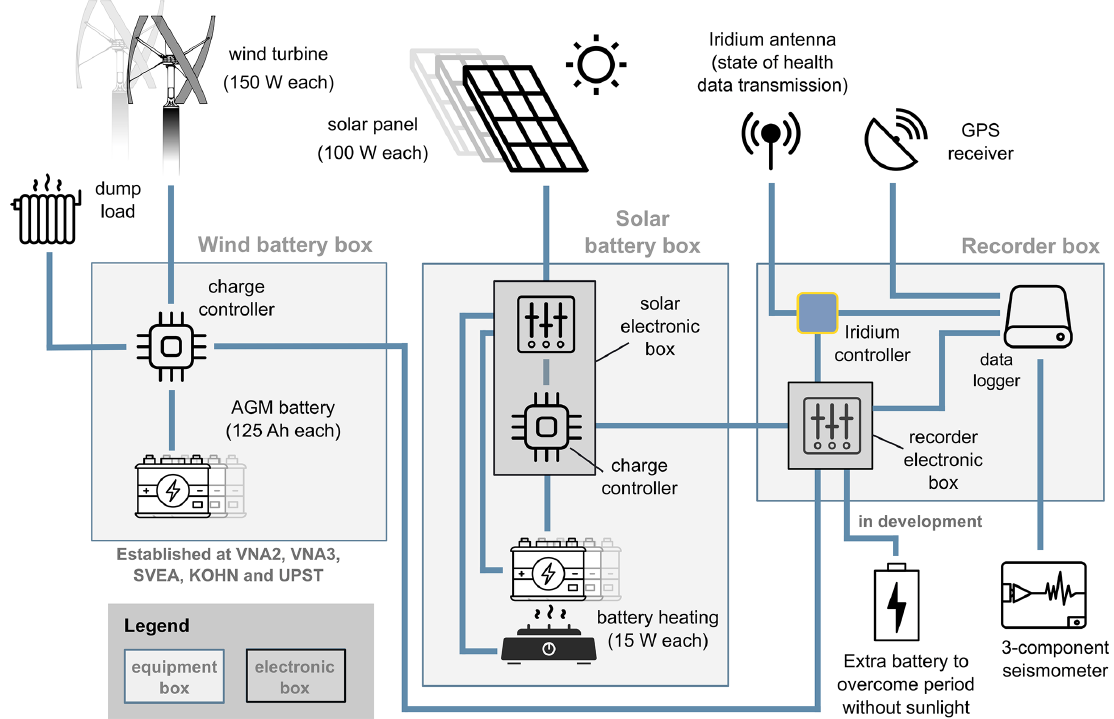
Figure 2. Schematic diagram of the instrument layout and power supply concept of our permanent and mobile seismic stations. Note that the station design for our mobile stations does not include the wind battery box. The wind battery box is, however, part of our permanent stations (VNA2, VNA3, SVEA, KOHN, and UPST; Fig.